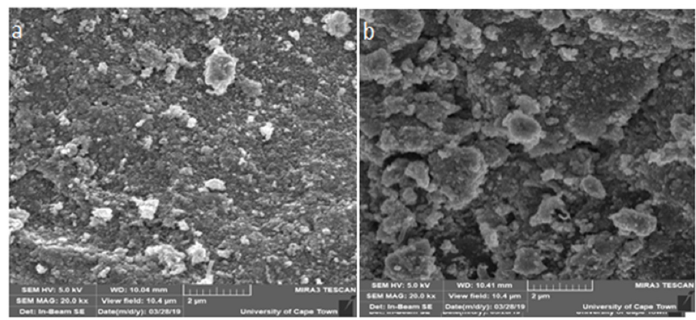
Figure 6. SEM images for CNC-MNPs ( a ) and CPC-MNPs ( b ).